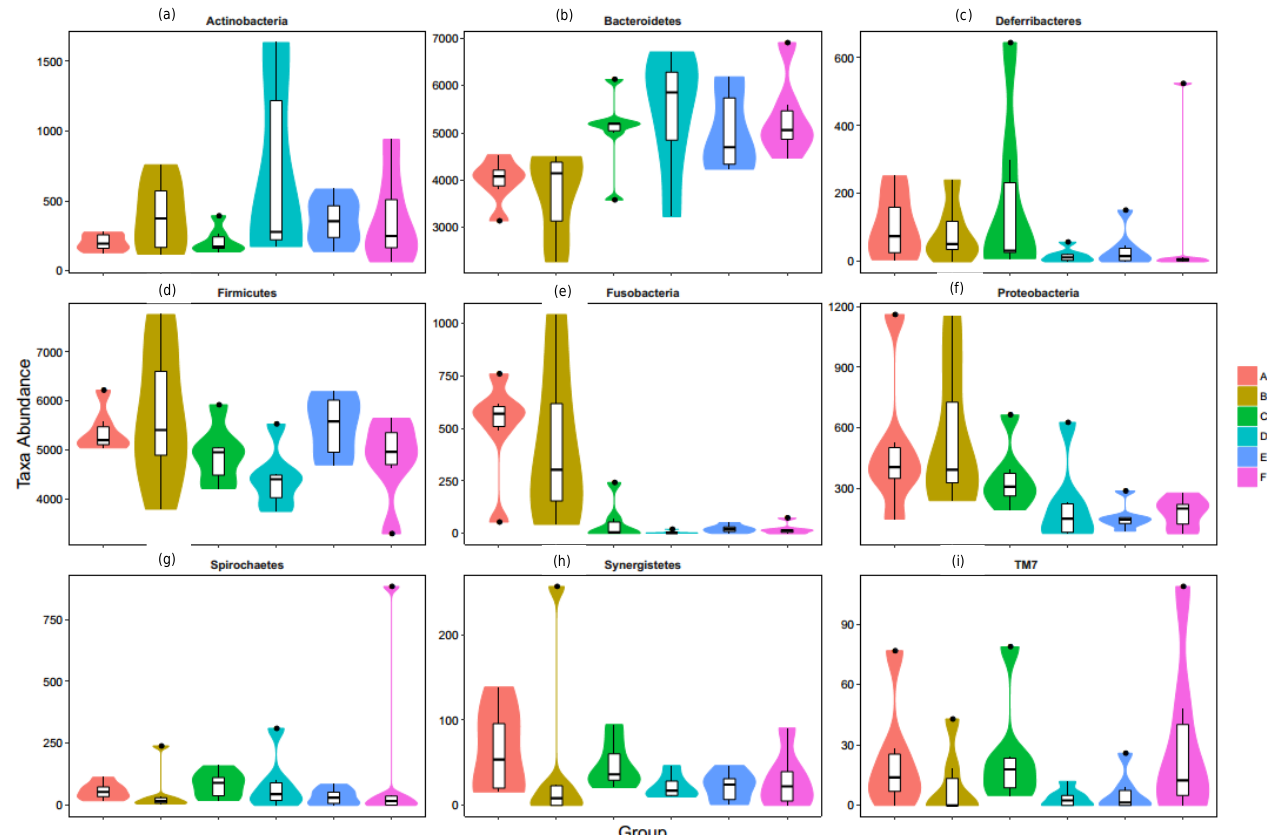
Figure 8. Relative abundance of phylum. ( a ) Actinobacteria; ( b ) Bacteroidetes; ( c ) Deferribacteres; ( d ) Firmicutes; ( e ) Fusobacteria; ( f ) Proteobacteria; ( g ) Spirochaetes; ( h ) Synergistetes; ( i ) TM7. Data are shown as the mean ± SEM. Each color represents the relative abundance of each diet group (A, B, C, D, E and F).